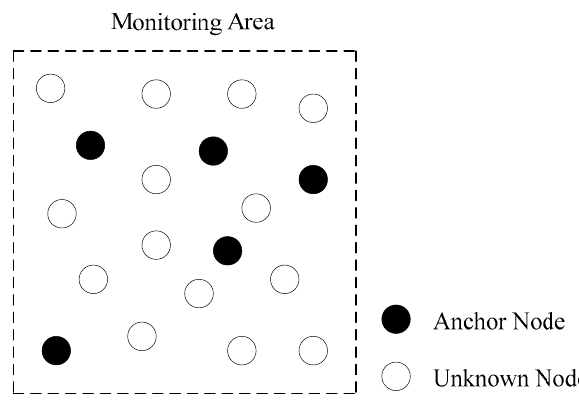
Figure 1. An example of wireless sensor networks (WSNs).